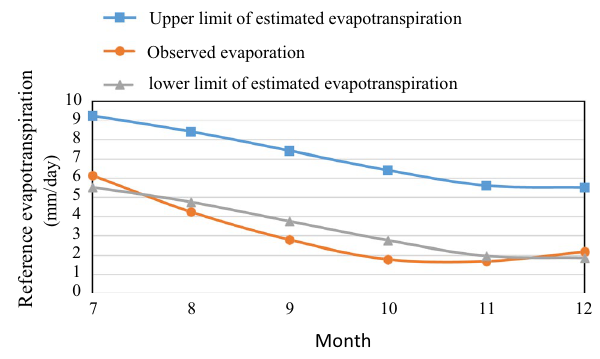
Fig. 3 Observed and predicted evapotranspiration charts (FAO Pen- man Monteith method)